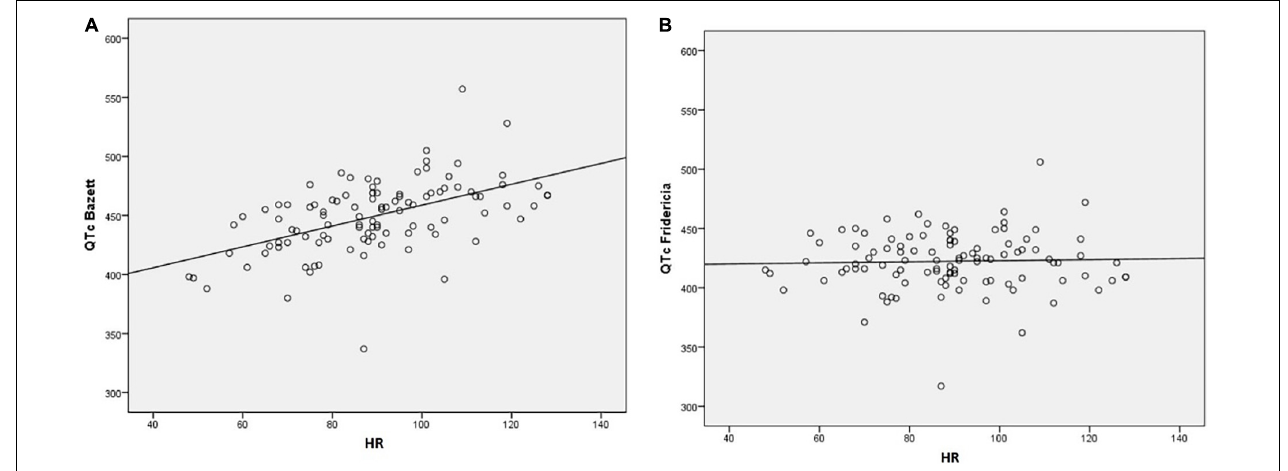
and (B) RR − distance ( s )